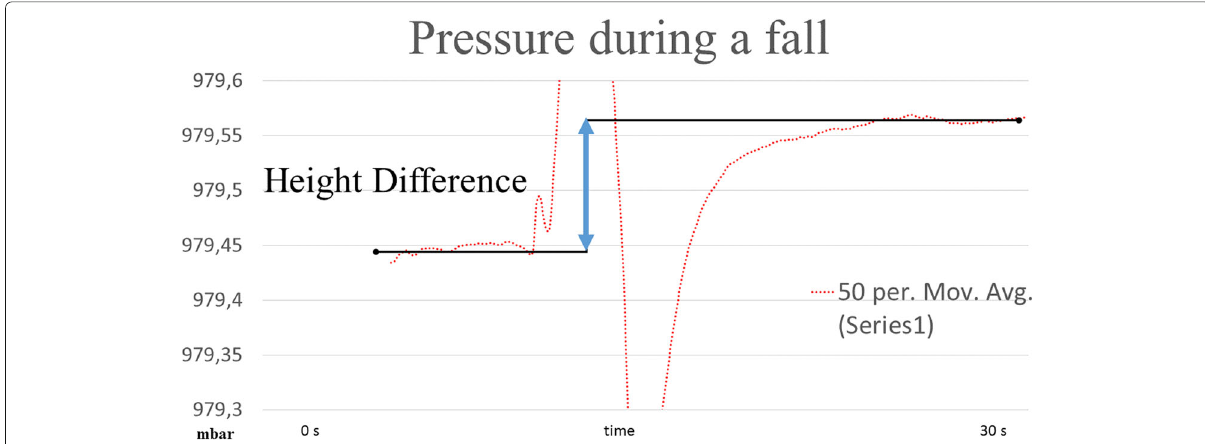
Fig. 3 Fall pattern measured with barometer. The average height difference in the windows before the fall and after the fall differs in terms of the height of the user standing and lying on the ground. During the fall itself, the precise barometer also detects air resistance; these data are therefore not usable and off the